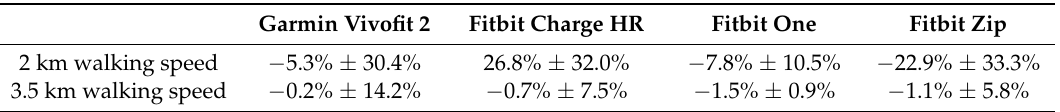
Table 2. Results from the walking tests shown as percentage difference between the Shimmer 3 and the self-monitoring devices. Values are shown as mean ± SD.